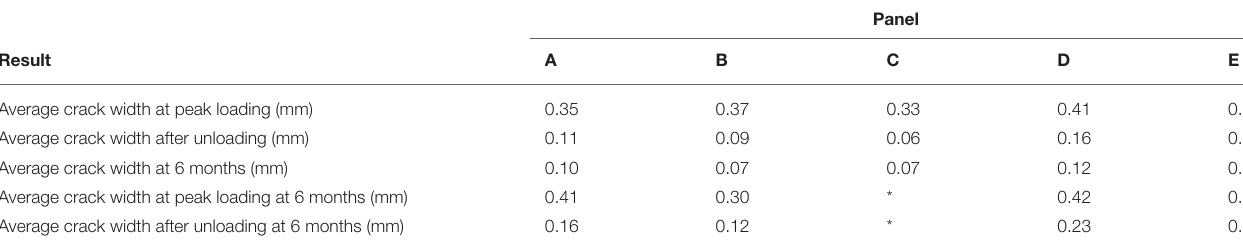
TABLE 5 | Crack widths during and after loading.